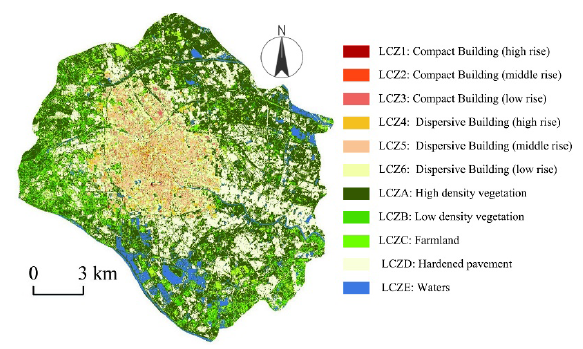
Figure 9. Distribution of LCZ in